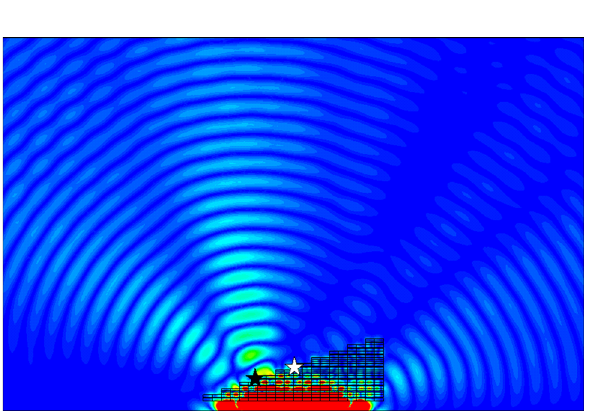
Figure 12. Absolute value of the electric field within and around a prism made of Du et al.’s metamaterial for various frequencies when a plane wave is incident upon it, based on a numerical simulation. Generated using CST Microwave Studio 30 .